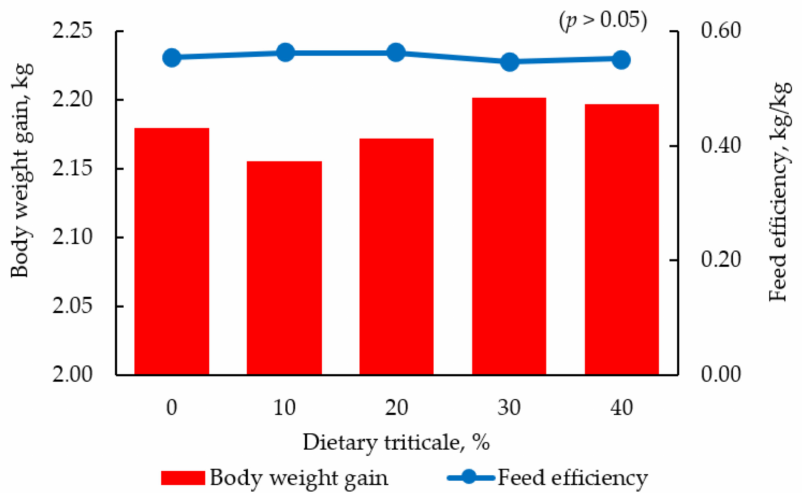
Figure 3. Body weight gain (kg) and feed efficiency (kg/kg) of broiler chickens fed diets containing increasing concentration of triticale from 1 to 42 d post hatching